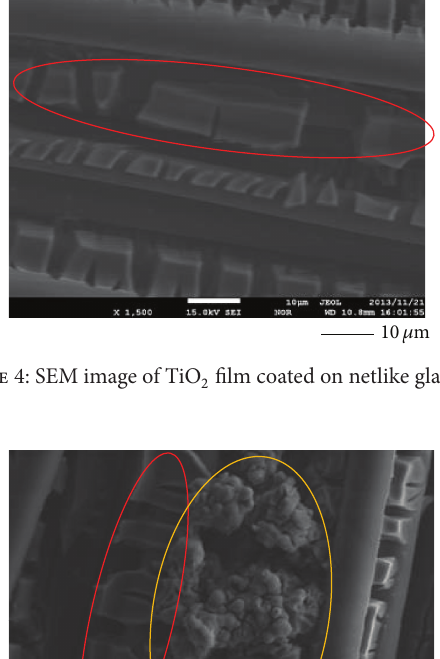
Ti and SiO 2 . Thermal conductivities of Ti and SiO 2 at 600 K are 19.4 W/(m ⋅ K) and 1.82 W/(m ⋅ K), respectively [22].